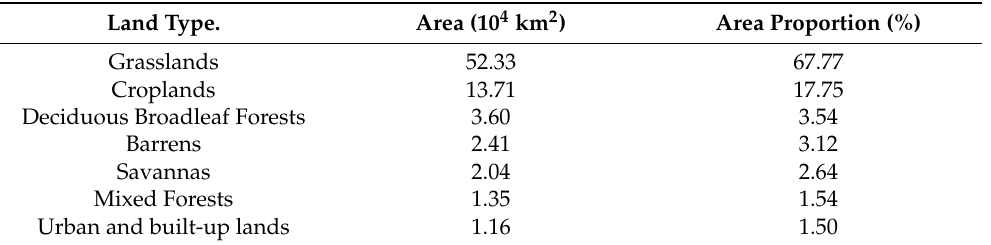
Table 1. The main land cover types (>10 4 km) and proportion of the upper and middle reaches of the YRB in